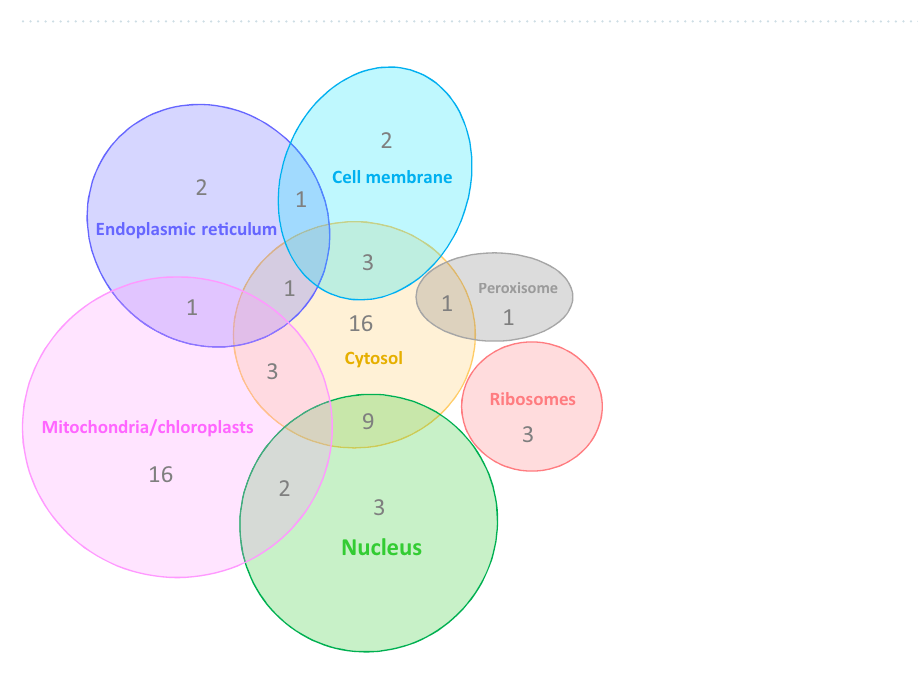
Figure 5. Categorization of infection induced antibody response protein targets according to Clusters of Orthologous Groups (COGs) characterizing the functional as well as topographical characteristics of identified protein groups as predicted by EggNOG v. 5.0.0. All identified protein targets by immune sera of both mouse models and all time intervals tested are summarized.